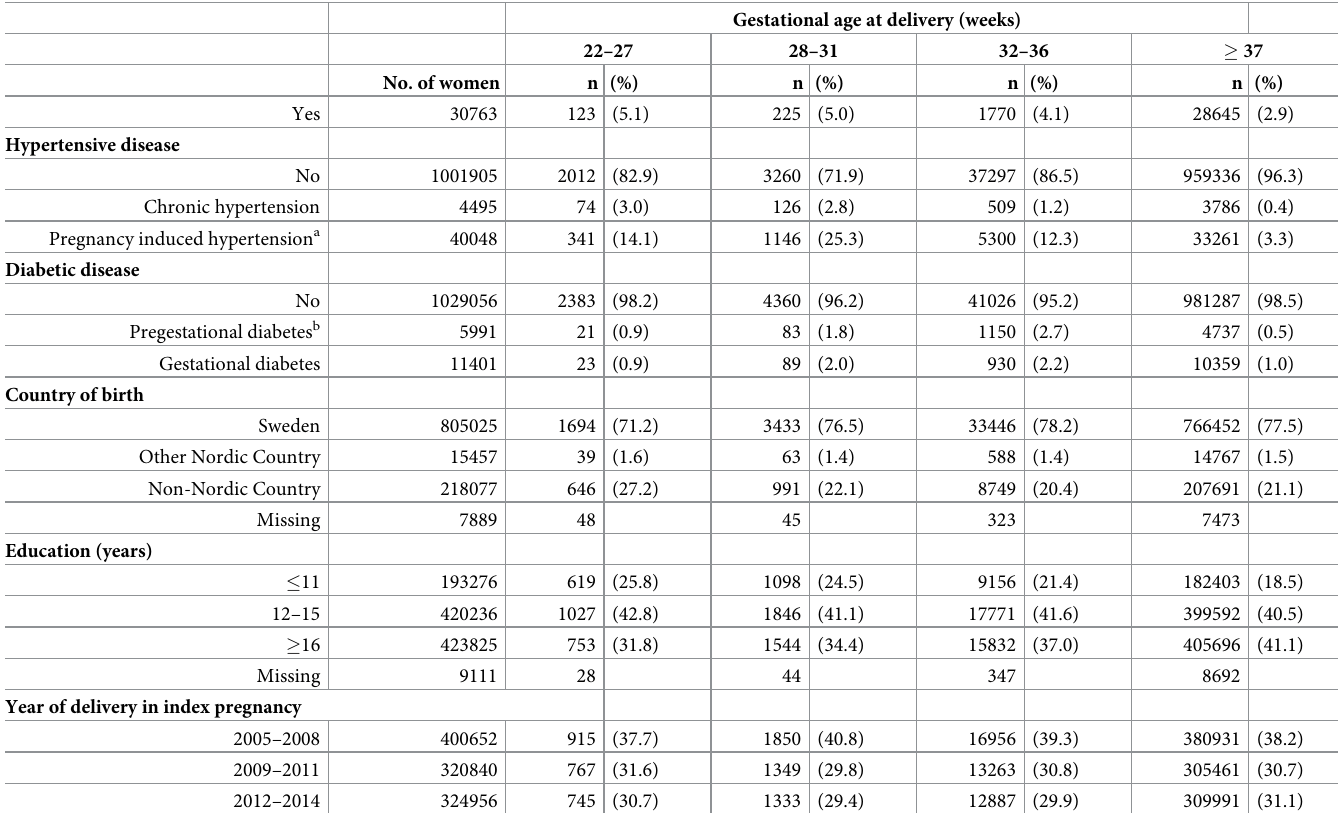
and 731 (5.4%) moderately preterm. The corresponding proportions were 0.2%, 0.4% and 4.1%, respectively, in women without PCOS. Comparisons of maternal characteristics according to preterm severity are shown in Table 2. Women who delivered preterm had PCOS more frequently, were more often either in the youngest or the oldest age categories, were more often primiparous, their mean height was lower, they had higher mean BMI and were more often smokers. They also more often had hypertensive or diabetic disease, both pre-gestational and pregnancy-induced disorders. Maternal characteristics in women with PCOS giving birth preterm compared to term are shown in S2 Table. Women with PCOS who delivered preterm were more often primipara, had higher mean BMI, more often smoked, had higher rates of infertility treatment and were more often born in countries outside of the Nordic countries than women with PCOS and term birth. Maternal PCOS was associated with a 43% higher risk of preterm birth (crude OR: 1.43, 95% CI 1.34–1.53). The association remained at the same level when we adjusted for maternal age, parity, smoking habits, country of birth and year of delivery (adjusted OR [model 1] = 1.41, 95% CI 1.31–1.52) and marginally decreased when we added BMI into the model (adjusted OR [model 2] = 1.34, 95% CI